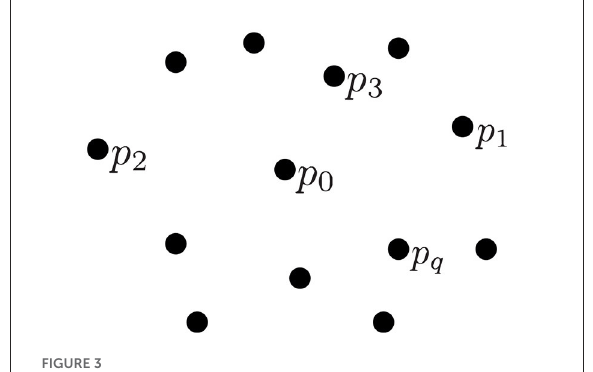
FIGURE3 Arbitrary distribution of